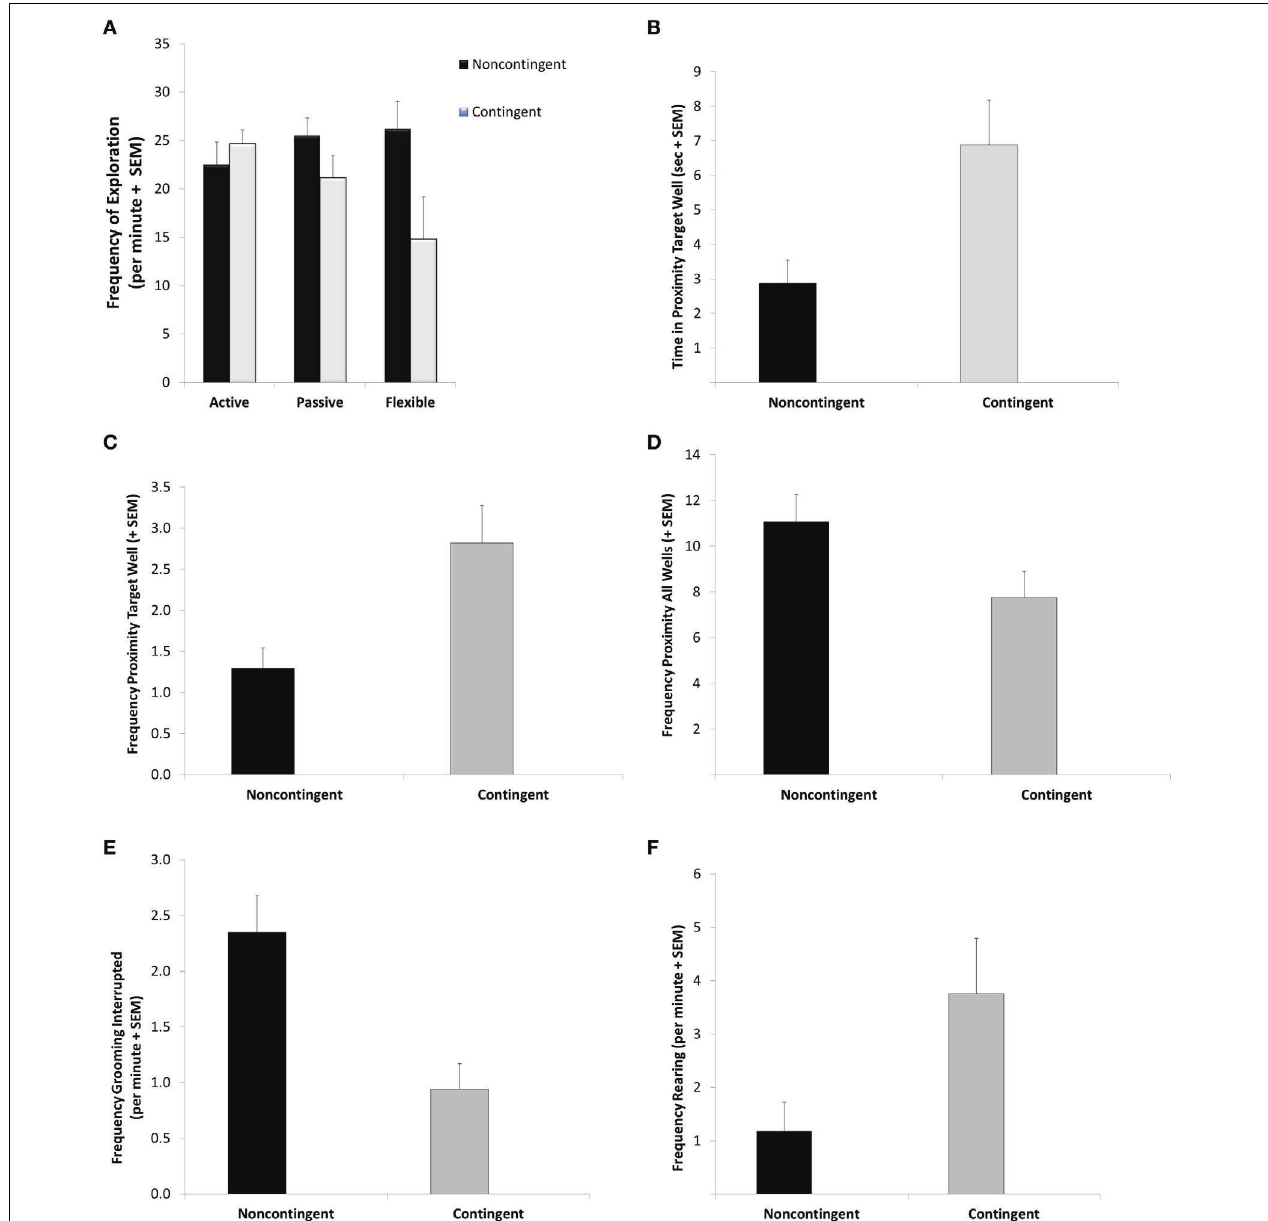
FIGURE 3 | Probe trial behavior. During the 5-min probe trial flexible contingent animals engaged in less exploratory behavior (A) further contingent animals spent more time in proximity to the previously baited well (B) visited the previously baited well more frequently (C)